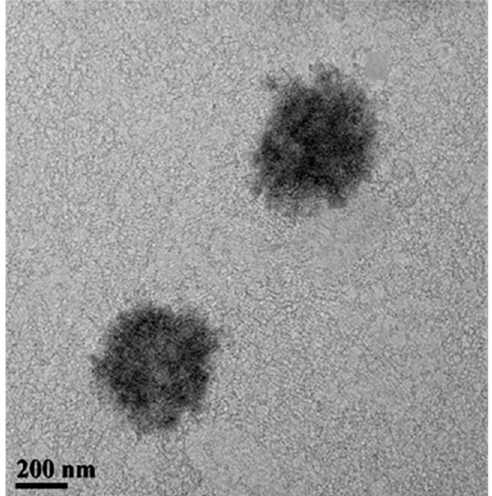
Figure 3. TEM image of the ZnO NCs presents ZnO@OAm NRs in form of nanocapsule. 2.2.2. Encapsulation Efficiency, Loading Capacity of NCs, and Release Profile of Geraniol from